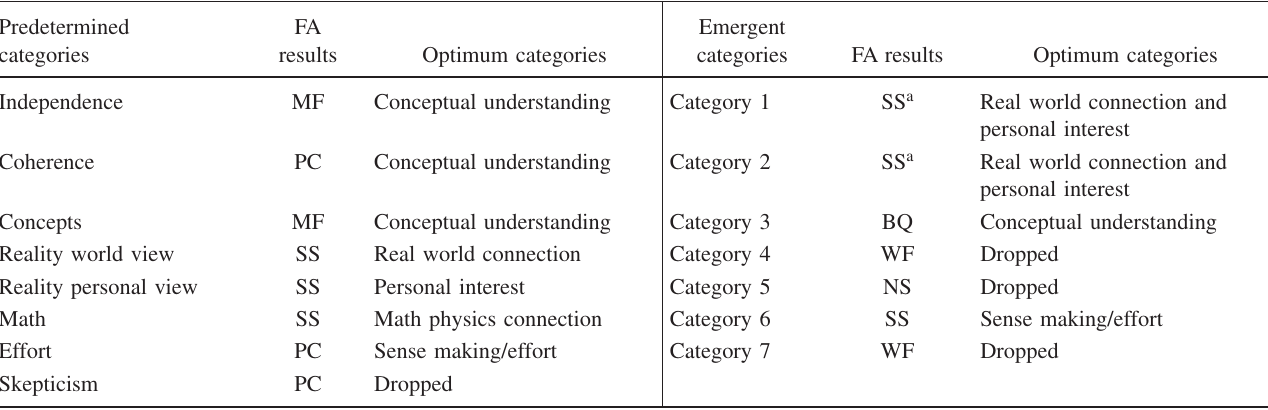
TABLE II. Reduced Basis Factor Analysis (cid:1) FA (cid:2) of Categories—CLASS V.2. SS=strong single factor; BQ=better with one or two